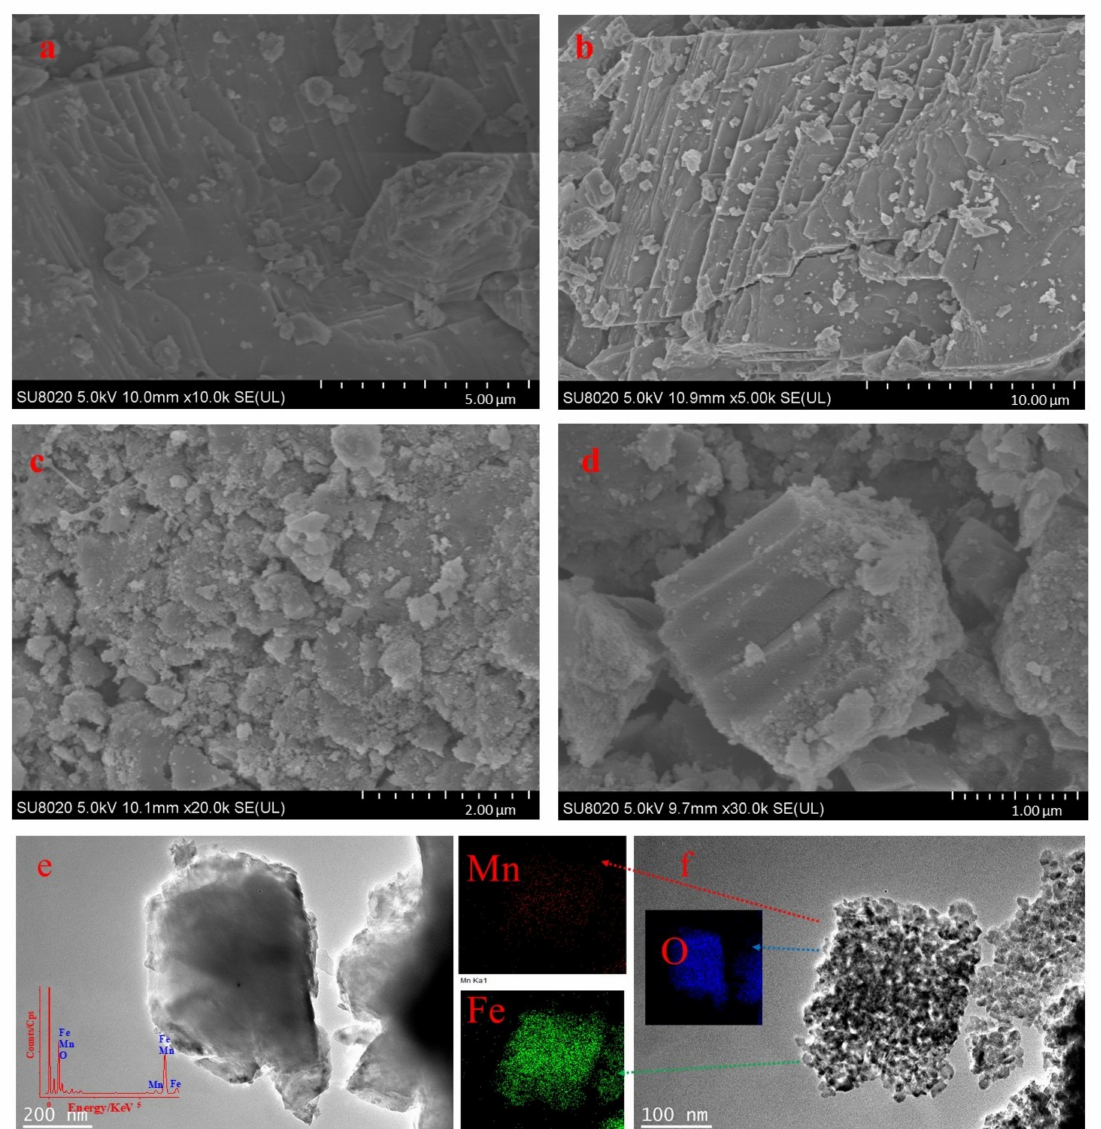
Figure 4. SEM images of ( a ) the natural siderite, ( b ) H500, ( c ) H550, and ( d ) H600, and TEM images of ( e ) the natural siderite, ( f )